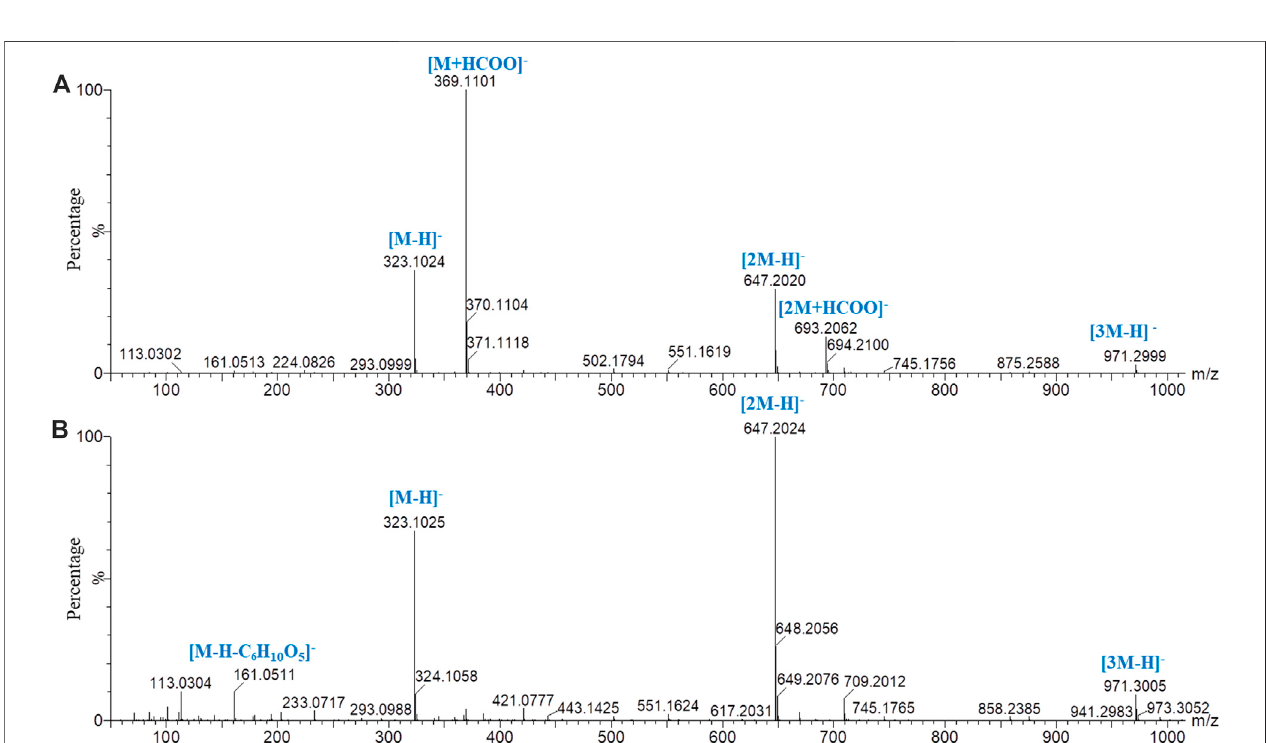
FIGURE 3 | Mass spectrometry of peak 3 in PMOR in negative ion mode with chromatographic condition 2. (A) Low-energy mass spectrometry; (B) high-energy mass spectrometry.